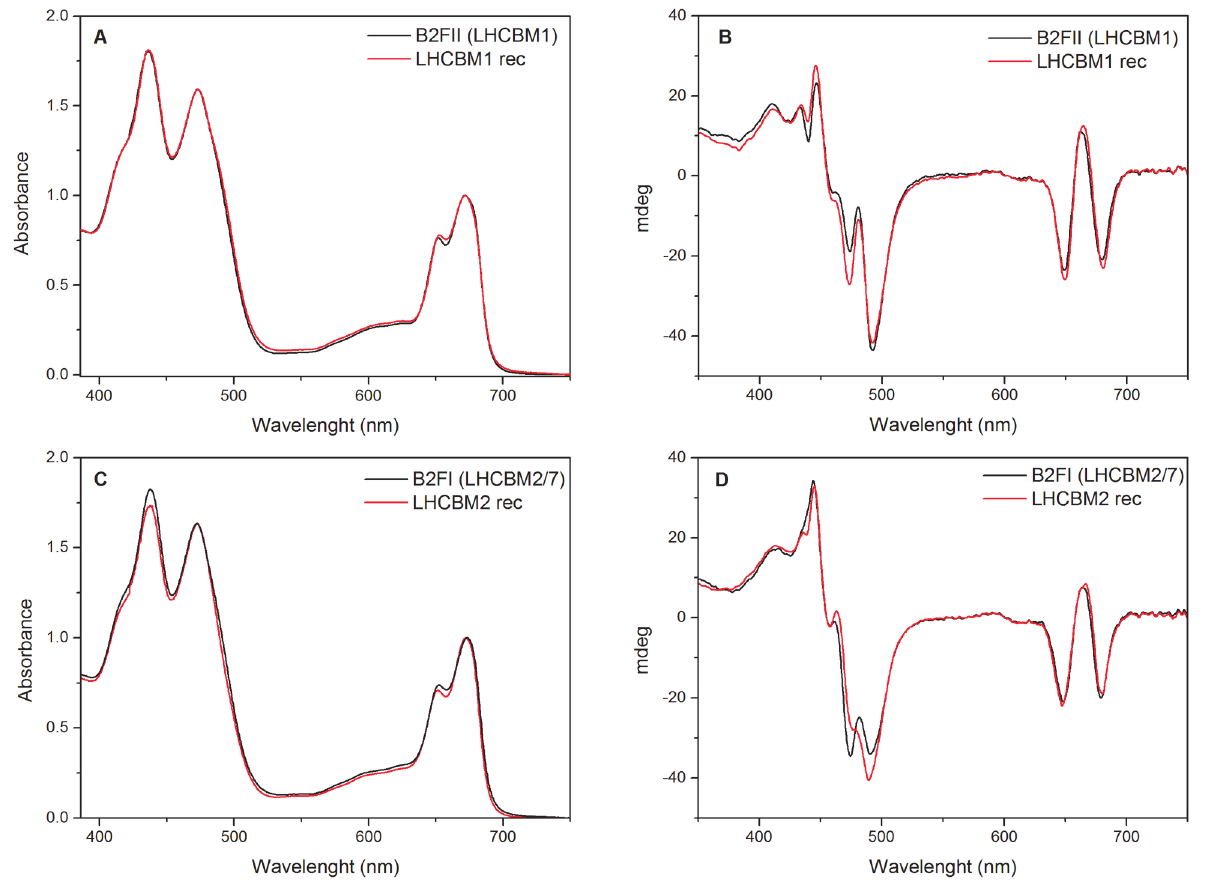
Fig 7. Comparison of the absorption (A – C) and Circular Dichroism (B – D)) of LHCBM1, LHCBM2 reconstituted and the purified fractions from ndIEF containing LHCBM1 and LHCBM2/7. The absorptions are normalized to the Q y peaks, while the CD signals are normalized on the absorption